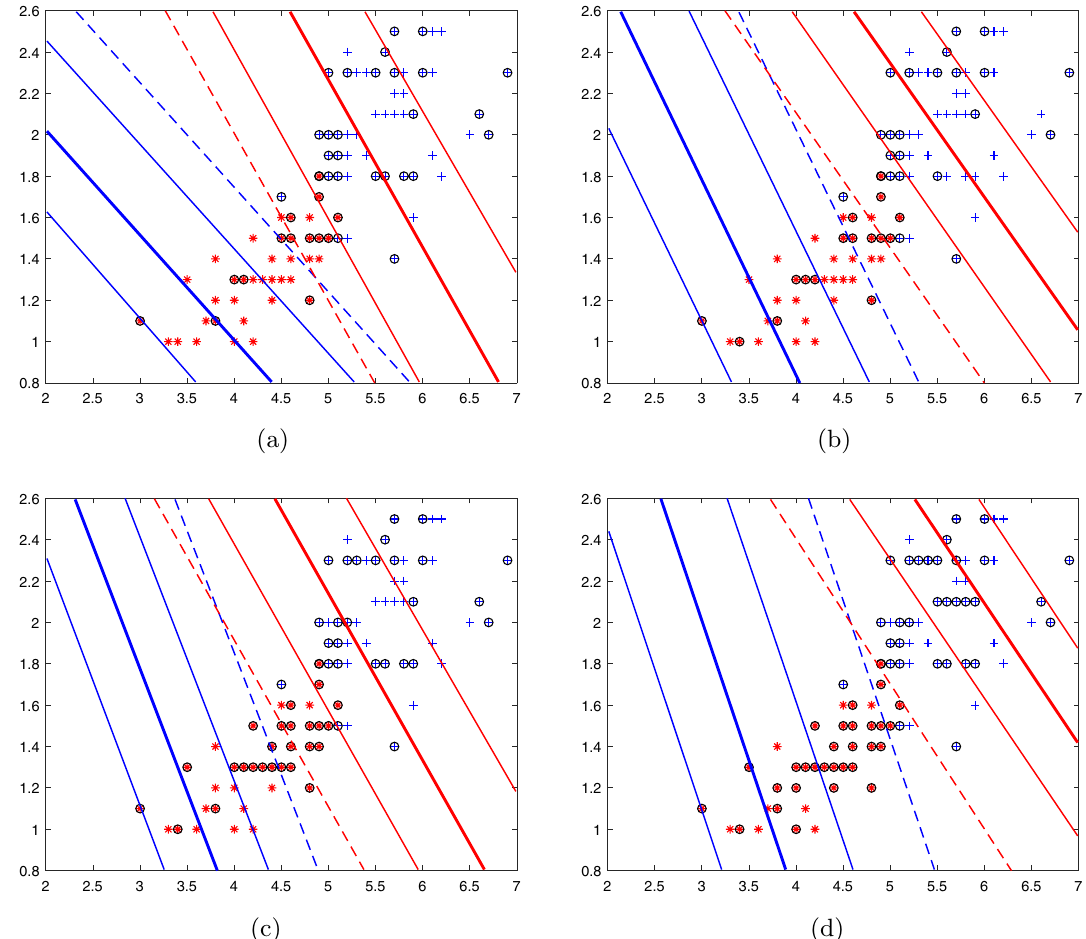
Figure 3. ν -IMNPSVM with the linear kernel: positive proximal line f + ( x ) = 0 (red thick solid line), negative proximal line f − ( x ) = 0 (blue thick solid line), positive ε -bounded lines f + ( x ) = ± ε + (red thin solid lines), negative ε -bounded lines f − ( x ) = ± ε − (blue thin solid lines), two margin lines f + ( x ) = − ρ + (red thin dotted line) and f − ( x ) = ρ − (blue thin dotted line). ( a ) ν =0.1, ( b ) ν =0.3, ( c ) ν =0.5, ( d ) ν